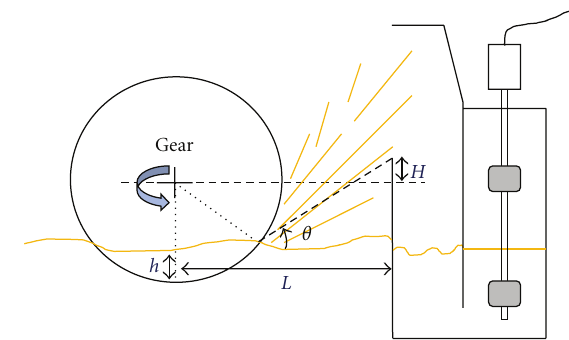
Figure 3: Definition of oil tank